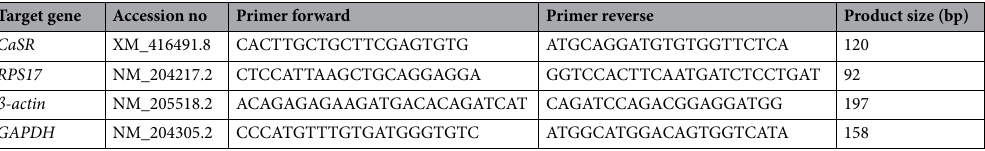
Table 1. Primers used for the reverse transcription q